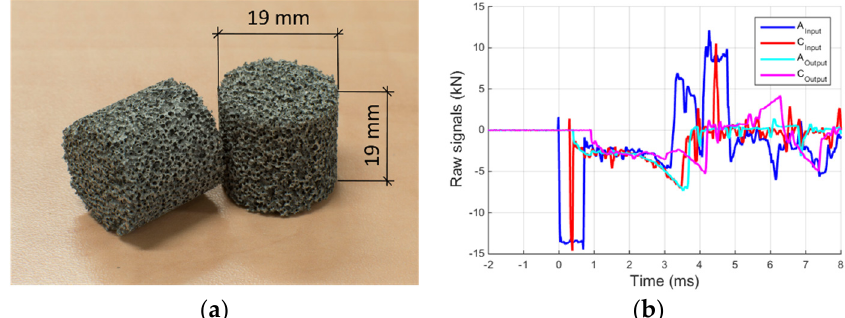
Figure 7. ( a ) Specimen of aluminum foam ALUHAB; and ( b ) raw signals recorded on the input and output bars on two locations.